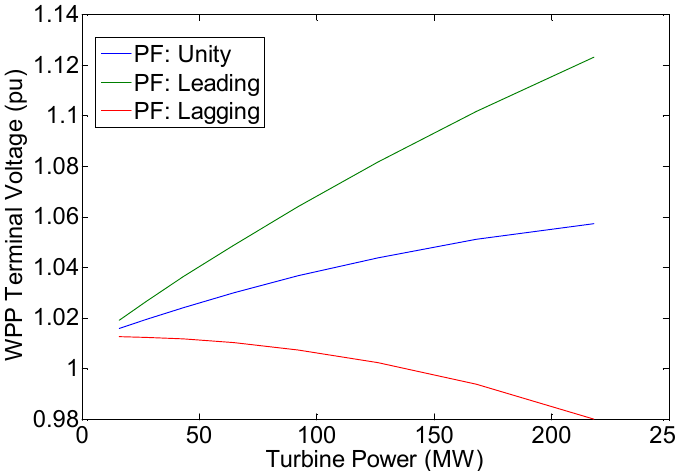
Figure 12. Variation of WPP terminal voltage.